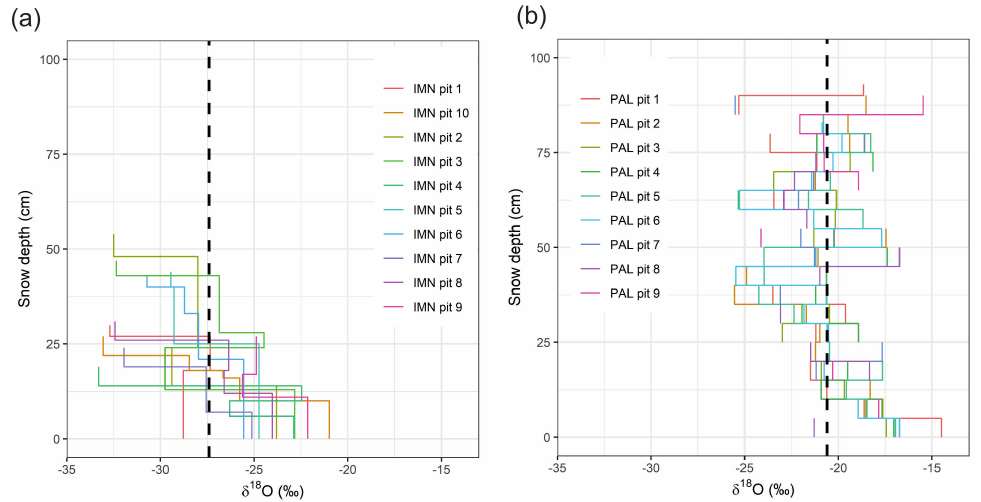
Figure 5. Snow δ 18 O and profiles for the sampled snowpits at ( a ) Imnavait and ( b ) Pallas. δ 18 O value in each sample is represented by a vertical line spanning the sampling depth. The dashed line indicates the mean δ 18 O value of all